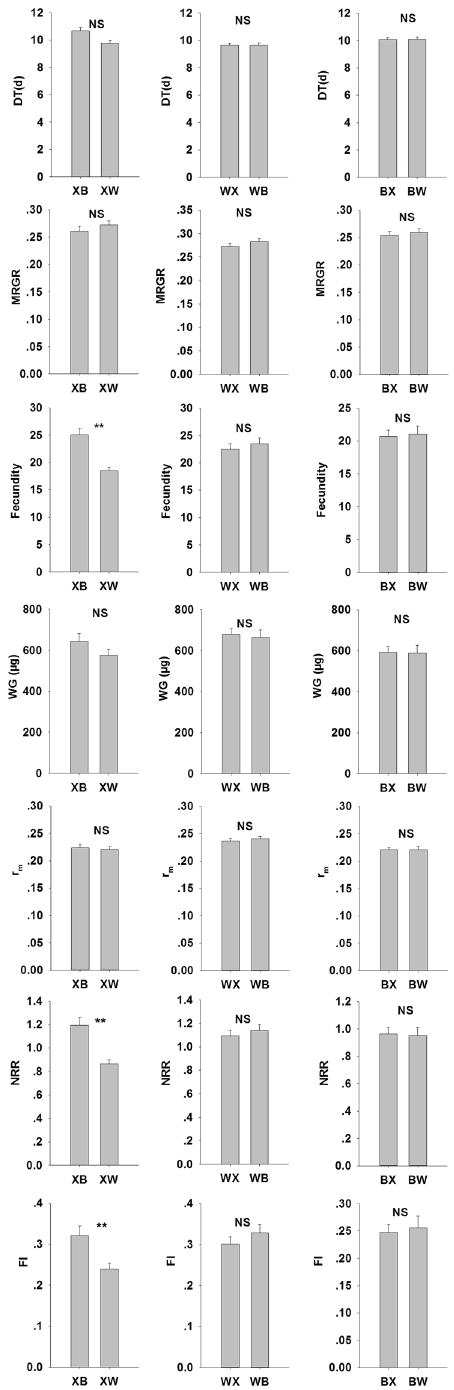
Figure 5. The life-history trait values of same population offspring aphids on different transition